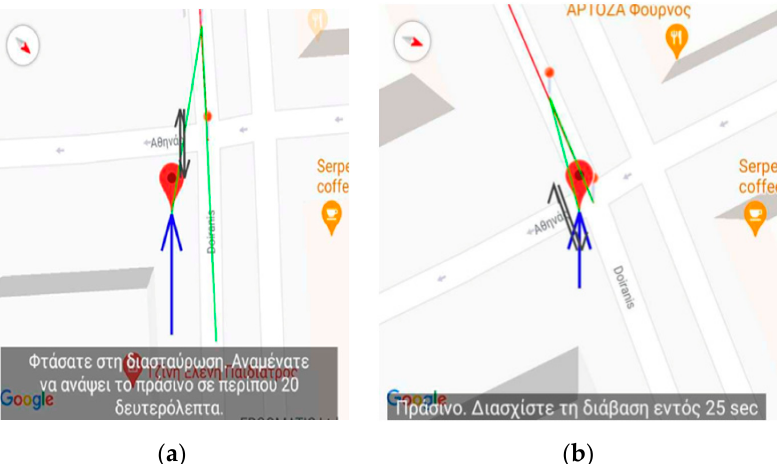
Figure 9. Application’s Training version—Snapshot from simulating the passage of the crossing near the traffic light of the Doiranis and Athinas junction in Kallithea. The translation of the issued message displayed on ( a ) is: “You have reached the intersection. Wait for 20 s until the traffic light status is green” while for ( b ) is: “Green. You can pass the crossing. Remaining time 25 s”.